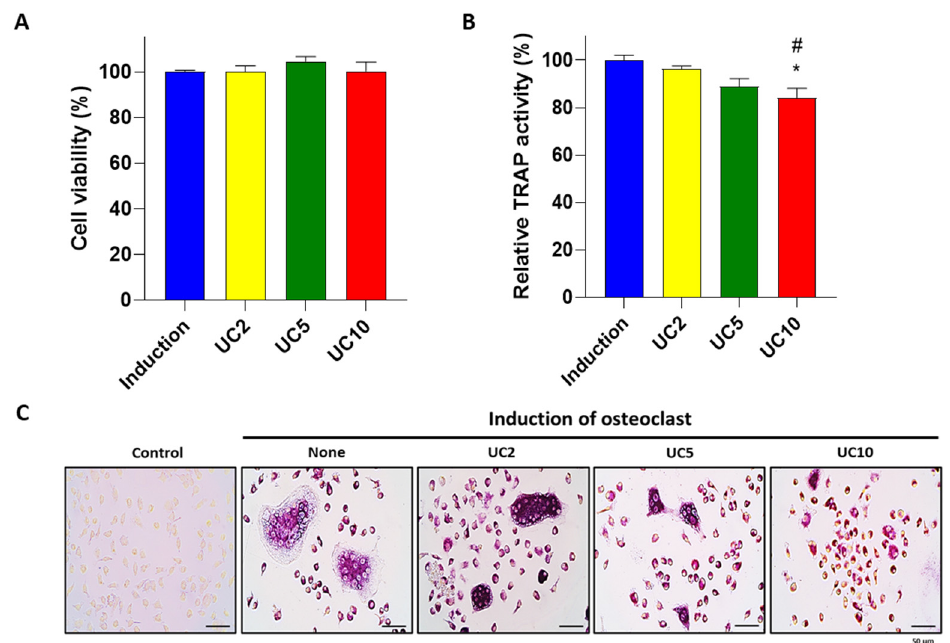
Figure 4. Effects of Ulmus davidiana (UD) and Cornus officinalis (CO) extract on osteoclast activity. Primary monocytes were co-treated with an osteoclast induction medium and 10 µ g/mL of UD, CO extract or their combination (8:2, 7:3 and 5:5). After 5 days of induction, ( A ) cell viability and ( B ) TRAP activity were evaluated. The results on the bar-graph are from three independent experiments. UD, Ulmus davidiana treatment; CO, Cornus officinalis treatment; * p < 0.05 vs. induction; # p < 0.05 vs. 8:2 (one-way ANOVA with Tukey’s multiple comparison test).